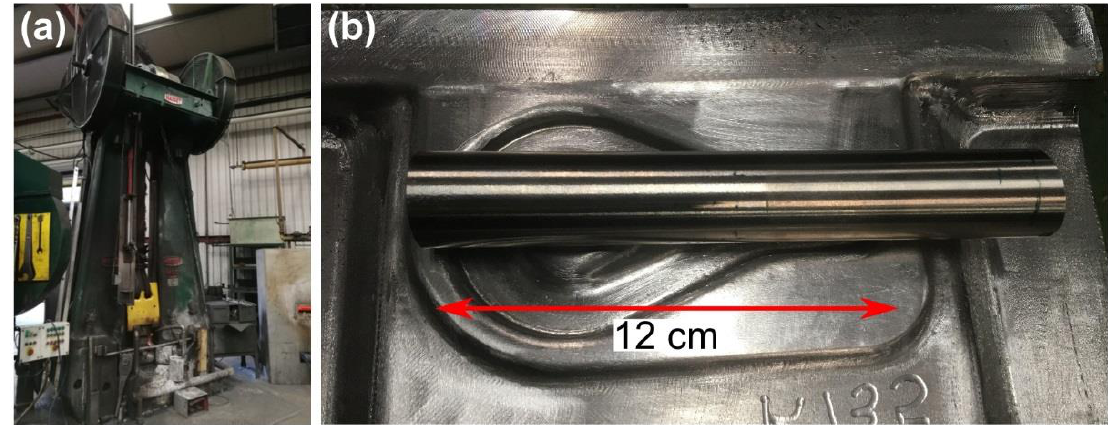
Figure 4. ( a ) Photograph of the Massey 1.1 MSC drop hammer forge used in forging trials at W.H. Tildesley Ltd; ( b ) Photograph of the eye-bolt geometry with a representative preform resting on